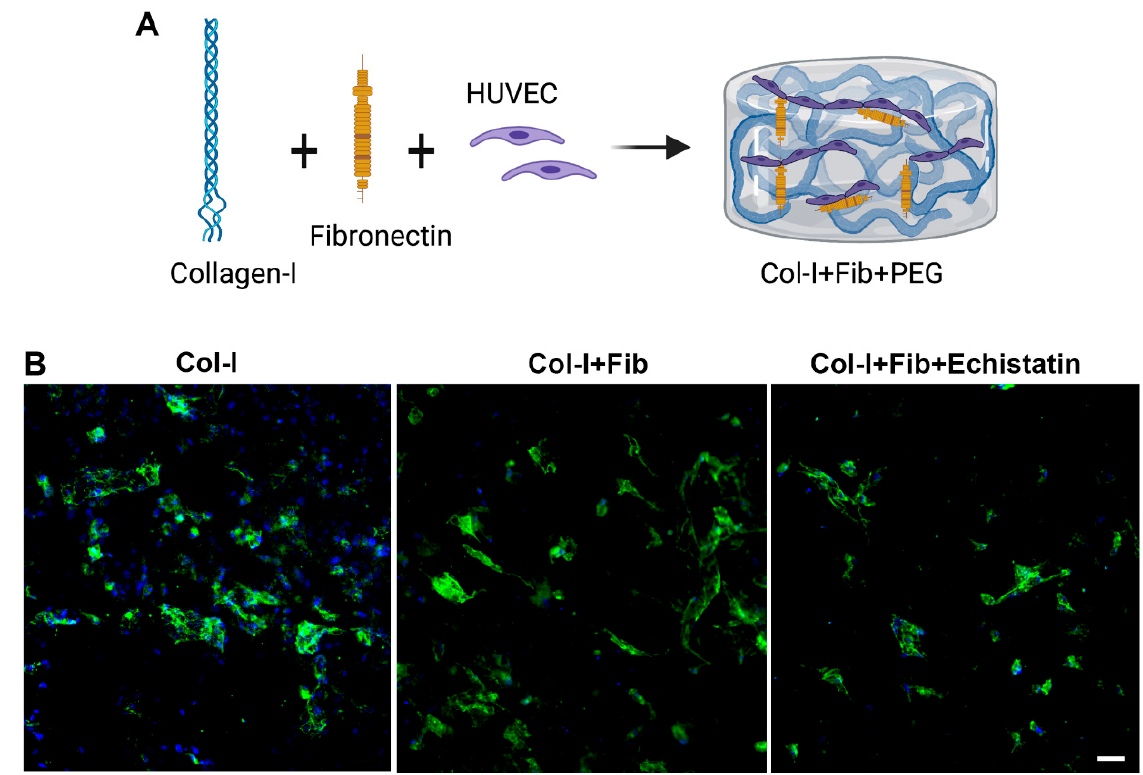
Figure 1. Characterization of HUVEC only hydrogels. ( A ) The schematic shows HUVEC in fibronectin functionalized collagen hydrogel-forming EC networks. ( B ) Fluorescent images of HUVEC-only hydrogels stained with CD144 on Day 7. The different hydrogels were collagen only (Col-I), fibronectin functionalized collagen hydrogel (Col-I + Fib), and Col-I + Fib hydrogel treated with Echistatin (Col-I + Fib + Echistatin). Dapi (Blue) was used to stain nuclei. The scale bar measures 50 µm.